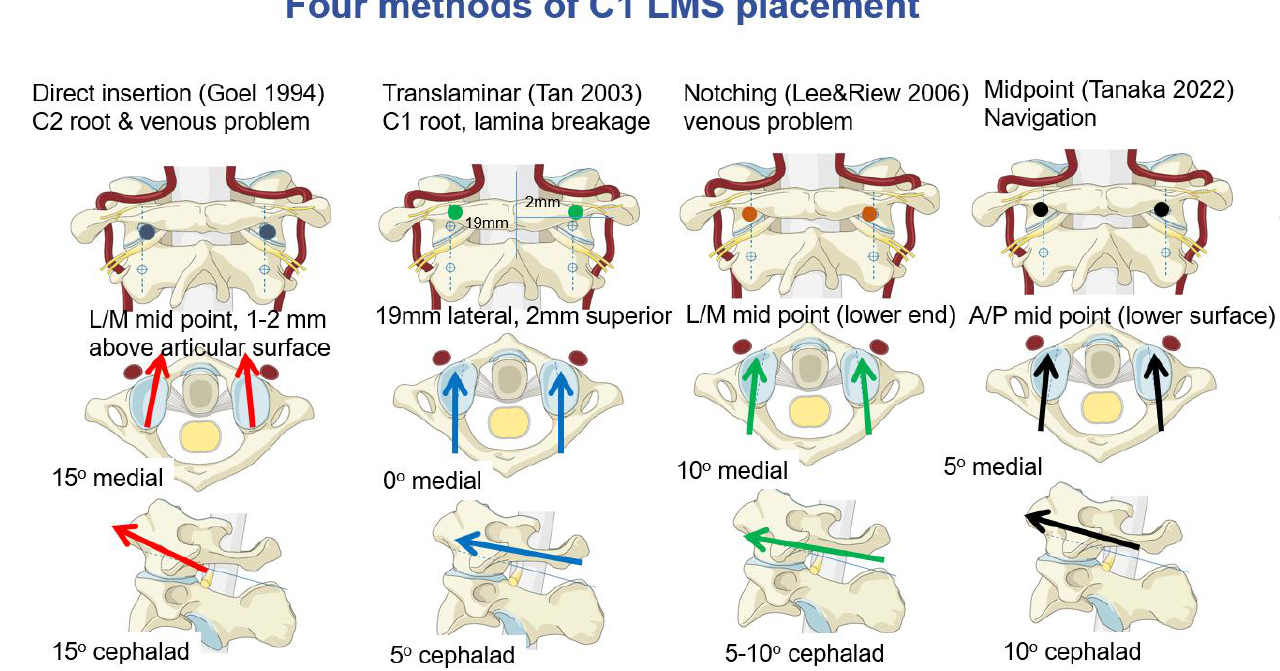
Figure 8. Four methods of C1 LMS placement [3,7,11]. red arrows, screw direction of Goel method; blue arrows, screw direction of Tan method; green arrows, screw direction of Noch method; black arrows, screw direction of Midpoint (our) method.